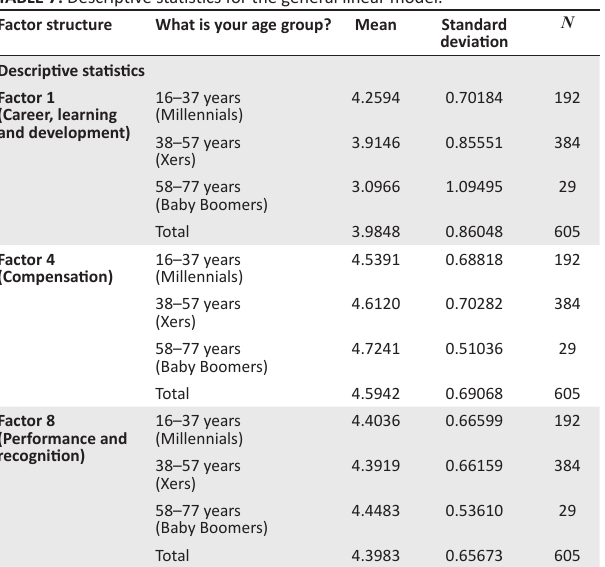
TABLE 7: Descriptive statistics for the general linear model. Factor structure What is your age group? Mean